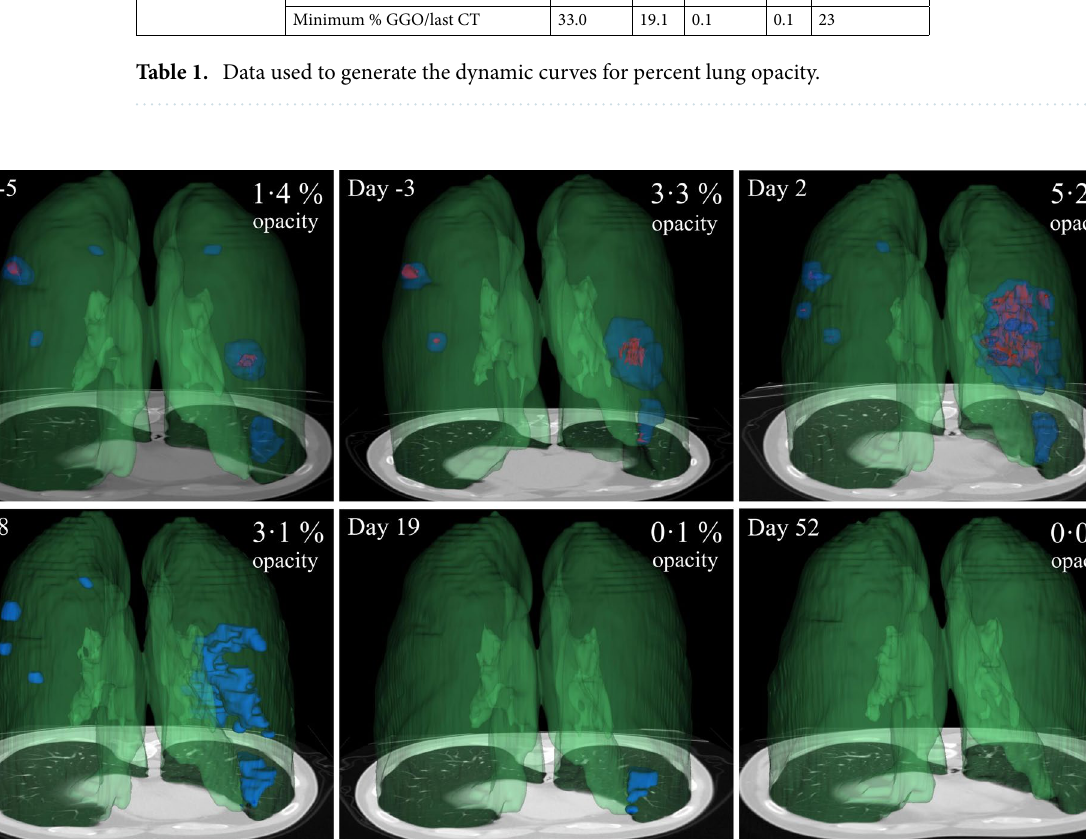
Figure 3. 3D model display of the evolution of COVID-19 opacities of 34 years old male from pre-symptomatic stage to convalescence. Symptom onset is day 0. Green shows 3D whole lung segmentation (derived from an AI model), blue shows GGO lesions, and red shows consolidation. The opacity volume (blue plus red) divided by the whole lung volume (green) is the percent lung opacity. Note normal hilar anatomy (dark